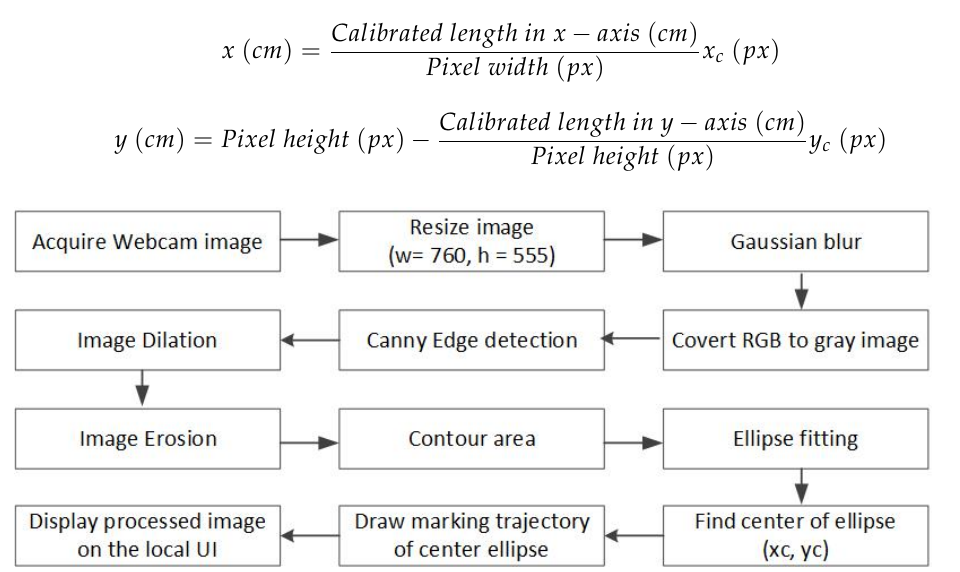
Figure 7. Block diagram of the image processing.